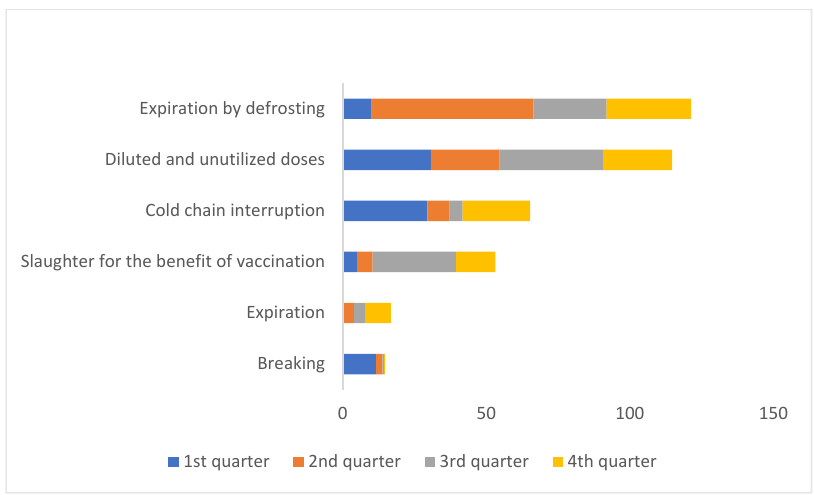
Figure 5. Quarterly distribution of COVID-19 vaccine losses by cause, Romania, 27 December 2020–31 December 2021.